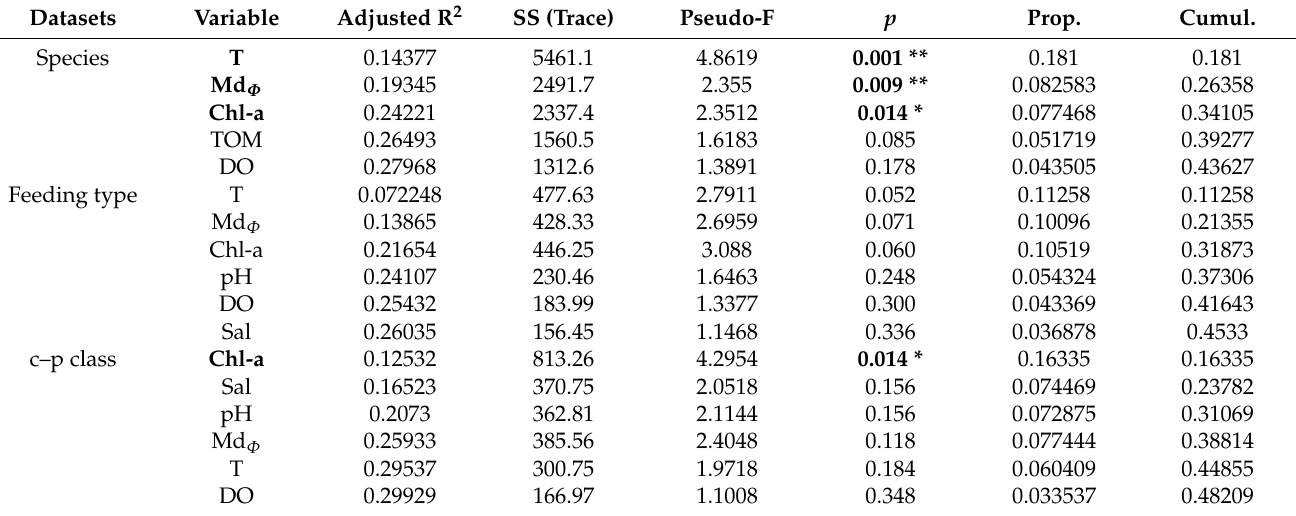
Table 5. Results of the DistLM sequential test for nematode datasets of XB. SS, sum of square; F, F statistic; Prop, the proportion of the variability explained; T, sea water temperature; Sal, sea water salinity; DO, sea water dissolved oxygen; Chl-a, Chlorophyll-a; TOM, total organic matter; Md Φ , median particle diameter. **, p < 0.01; *, p < 0.05. Statistically significant correlations are indicated in bold.